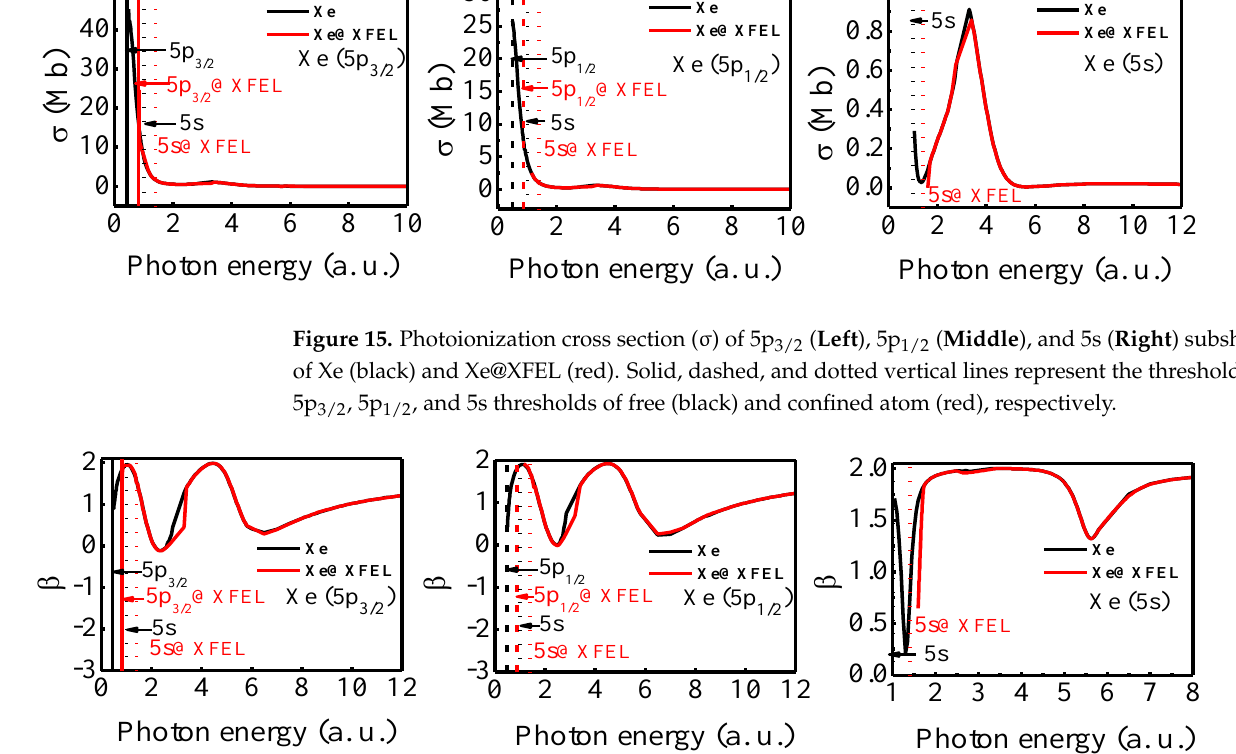
Figure 16. Angular distribution asymmetry parameter (β) of 5p 3/2 (Left), 5p 1/2 (Middle), and 5s (Right) subshells of Xe (black) and Xe@XFEL (red). Solid, dashed, and dotted vertical lines represent the threshold for 5p 3/2 , 5p 1/2 , and 5s thresholds of free (black) and confined atom (red), respectively.